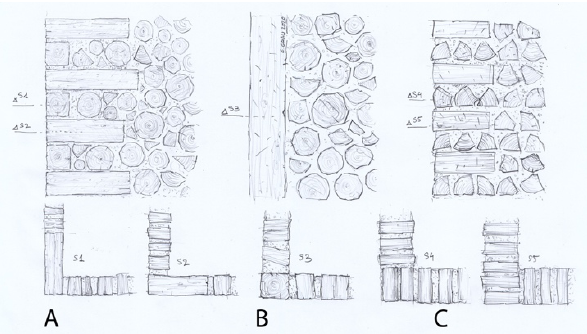
Figure 8. Drawing by the author of the different corners in load- bearing stovewood walls (Drawings: C.J. Grau,